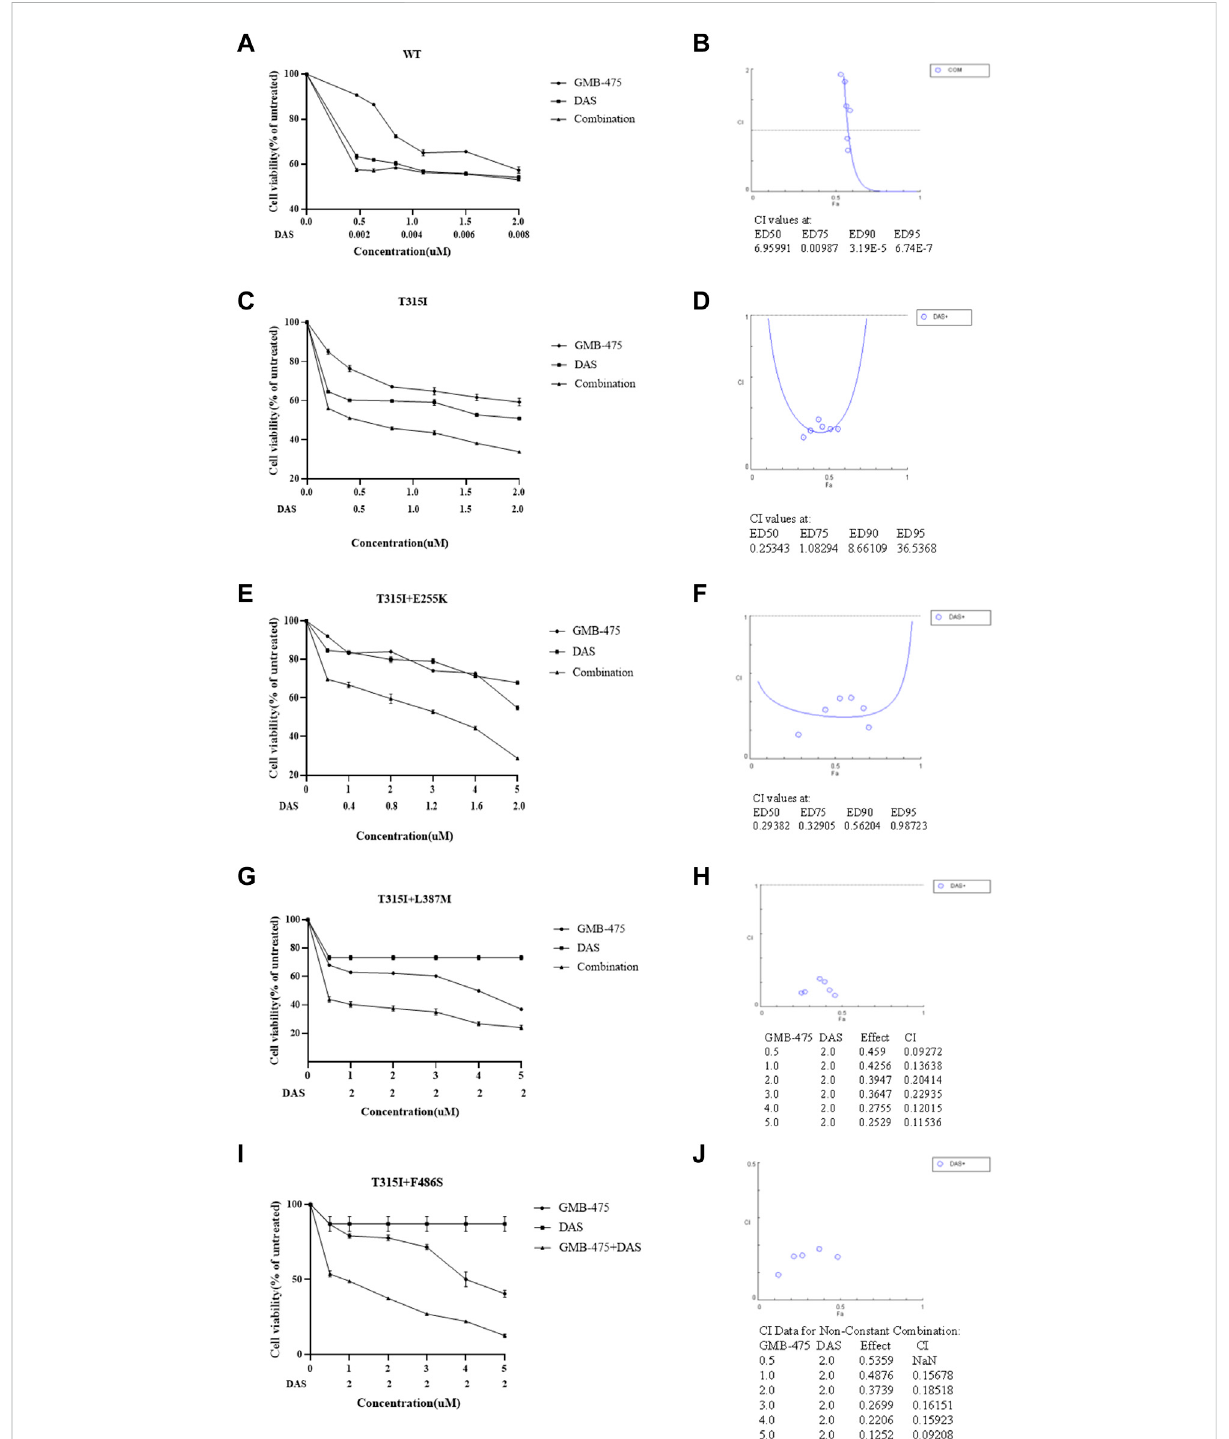
FIGURE 4 GMB-475combined with dasatinib (DAS) had synergisticeffects on thegrowth inhibition ofBa/F3-MIG-p210 cells with BCR::ABL1 mutantsbut no synergistic effect on that with BCR::ABL1 WT . (A,C,E,G,I) The viability of Ba/F3-MIG-p210 cells carrying BCR::ABL1 WT , BCR::ABL1 T315I , BCR:: ABL1 T315I+E255K , BCR::ABL1 T315I+L387M , or BCR::ABL1 T315I+F486S mutations treated with different concentrations of GMB-475, dasatinib, or GMB-475 plus dasatinib for 48 h was detected using the CCK8 assay. The abscissa represents the concentrations of GMB-475, and the corresponding concentrationsofdasatinibaremarkedbelowtheabscissa;theordinateisthecellsurvivalrate. (B,D,F,H,G) Thecurve fi guresofcombinationindexes (CIs); the CIs of GMB-475 combined with dasatinib at ED50, ED75, ED90, and ED95, or the CIs for different concentrations of GMB-475 combined with 2-µM dasatinib are shown below the fi gures; the CI at ED50 was the overall